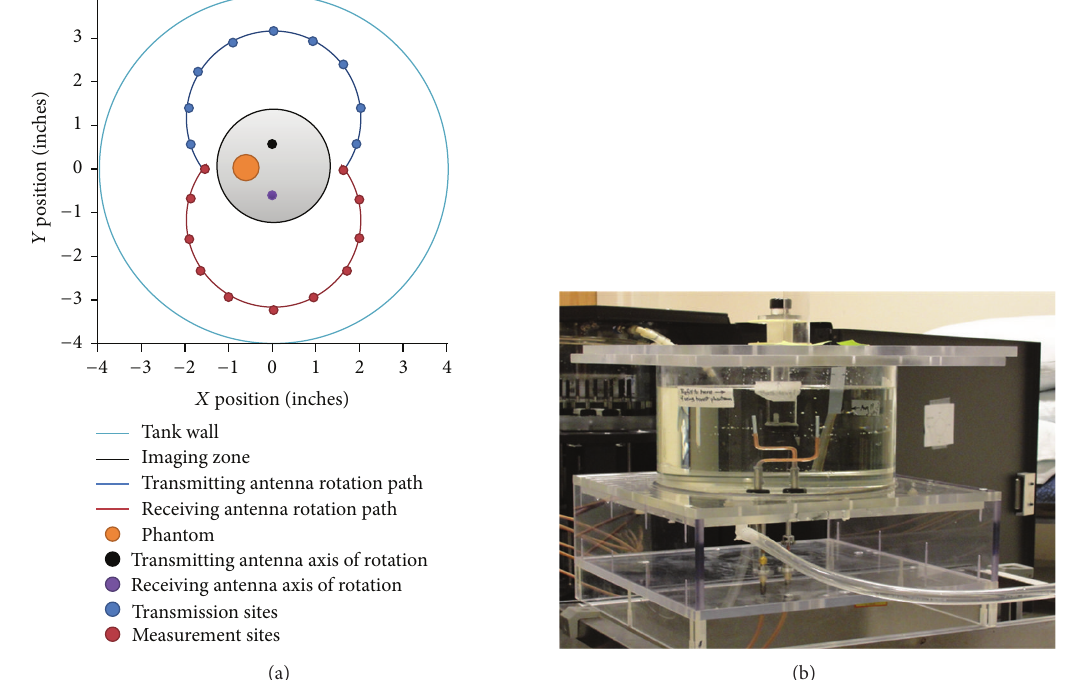
Figure 3: (a) 2D schematic of the experimental-imaging set-up and (b) side-view photograph of the imaging chamber with inclusion region during data